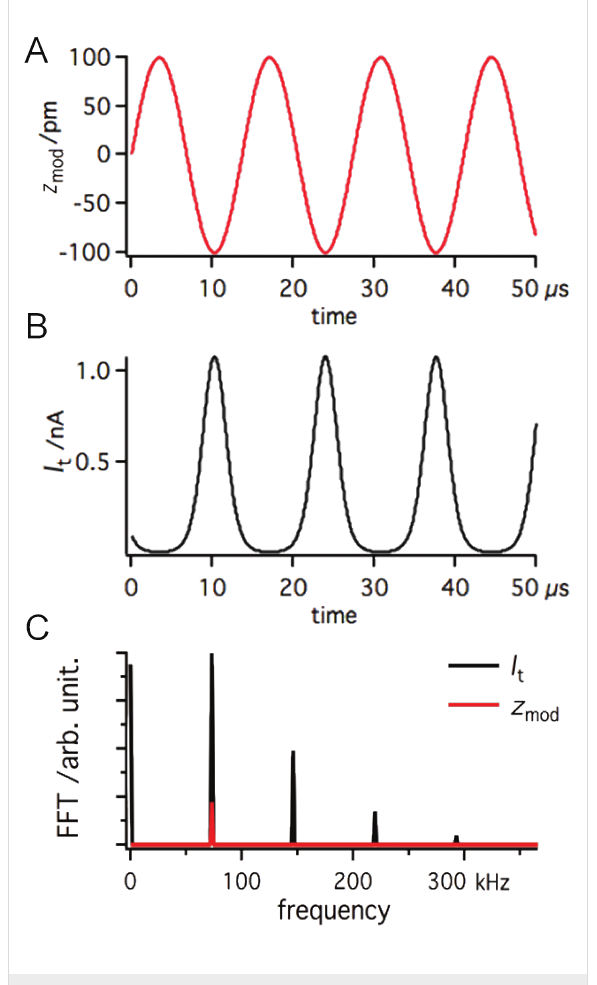
Figure 1: The effect of z modulation (A) on the tunneling current (B). a mod = 0.1 nm and f 0 = 73180 Hz; I t calculated by using I t ( z ) = I 0 e − 2 κ z where κ I = 11.9 nm − 1 and I 0 = 0.1 nA. In order to see better, the frequency distribution FFT is also shown (C).